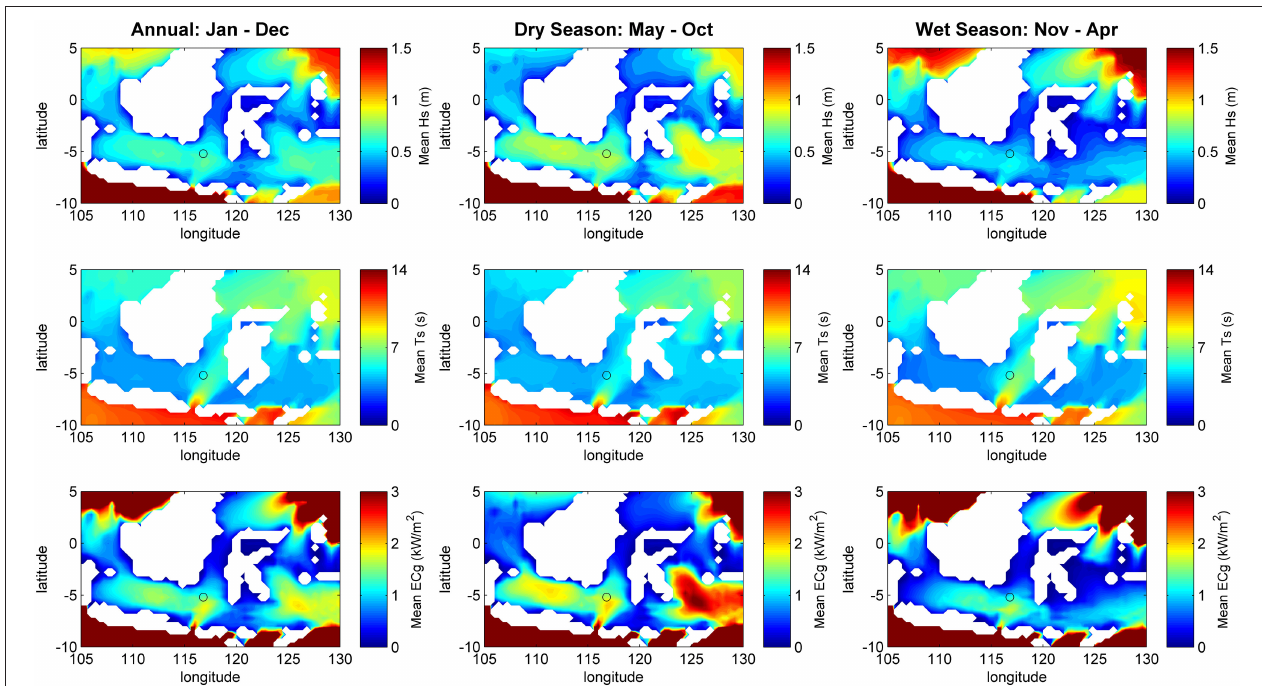
FIGURE 3 | Regional map of annual and seasonal wave properties. Mean significant wave height (Top) , significant wave period (Middle) and wave energy flux (Bottom) . Data averaged from hourly WWIII records spanning 30 years (1980–2010) for all months (Left panel) , the dry season (center) and the wet season (Right)